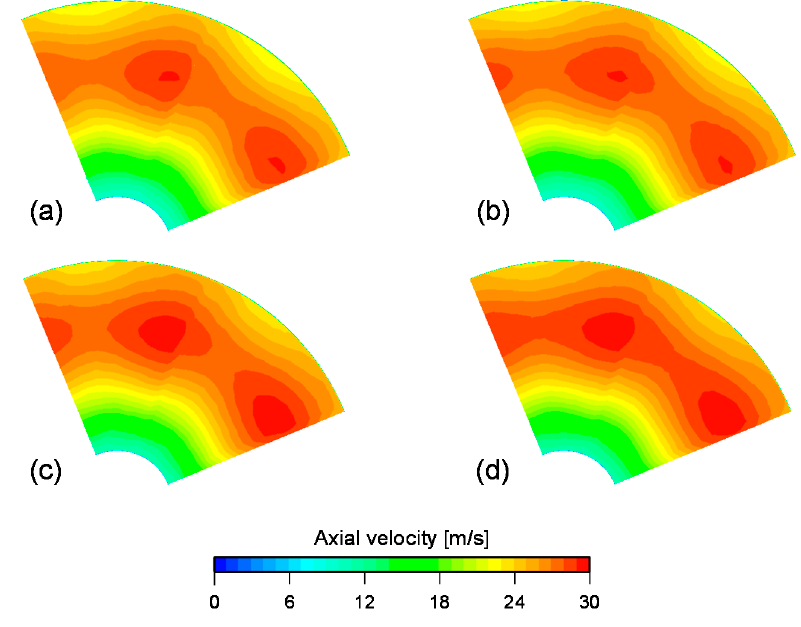
Figure 10. Axial velocity contour in Plane 4 at 2700 rpm for ( a ) 𝜃 = 6°, s = 120 mm; ( b ) 𝜃 = 6°, s = 200